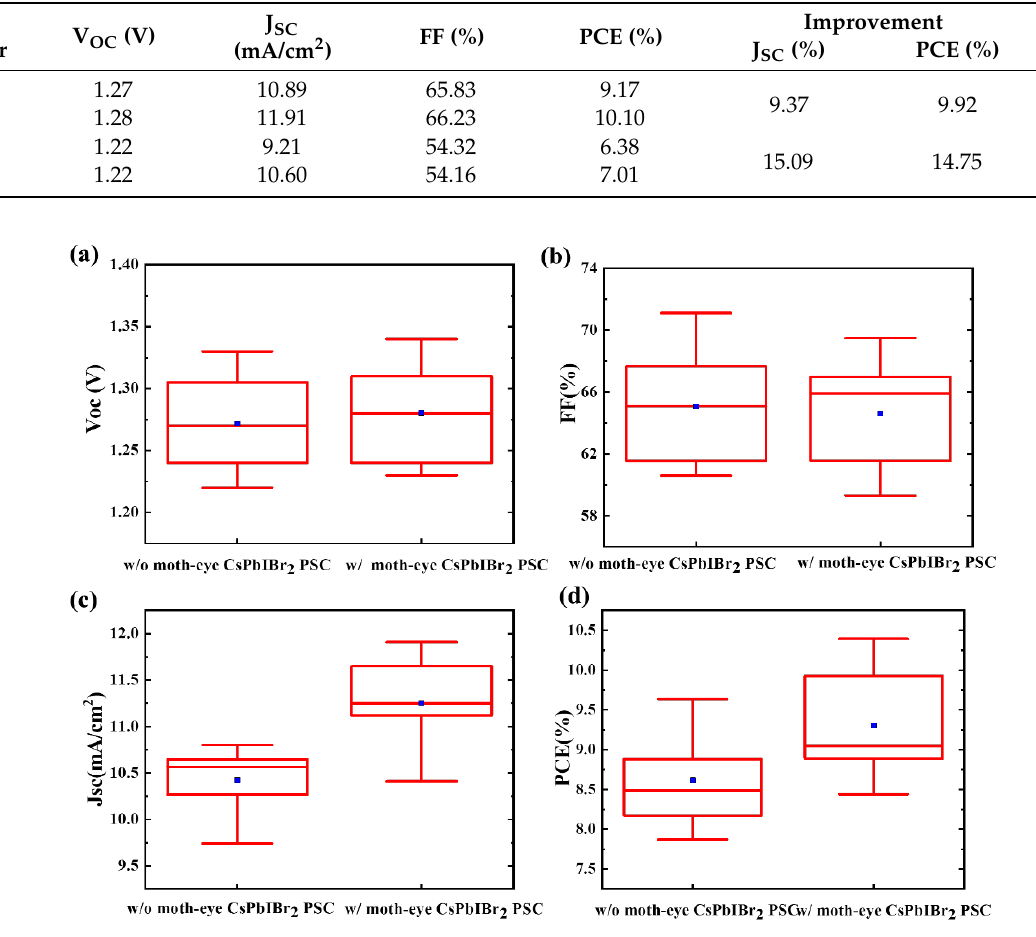
Figure 3. ( a ) V OC , ( b ) FF, ( c ) J SC , and ( d ) PCE statistics of 20 devices with moth-eye structure and 20 devices without moth-eye structure.